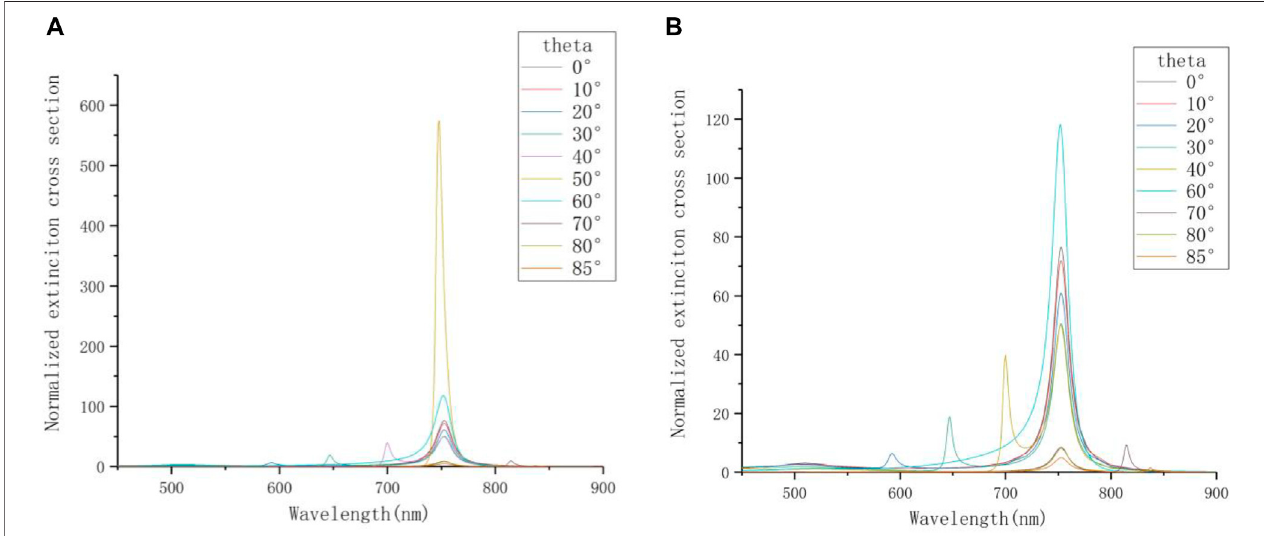
FIGURE 5 | (A) The extinction spectrum at different incident angles. (B) The extinction cross sections at different incident angles except θ (cid:1) 50 ° .